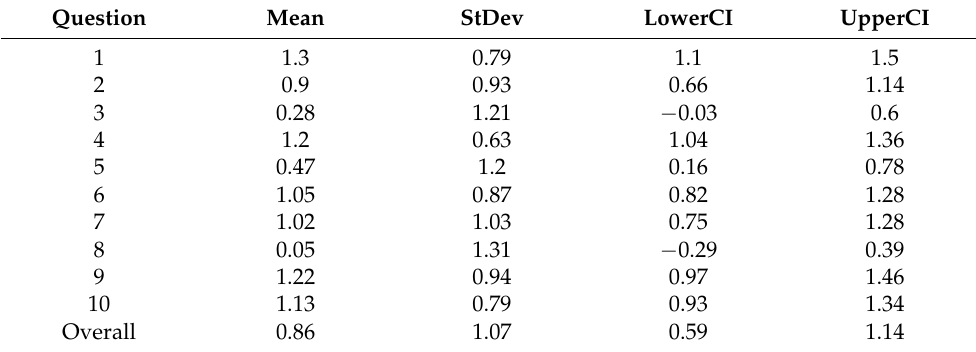
Table 2. Mean scores (combined) with 95% Confidence